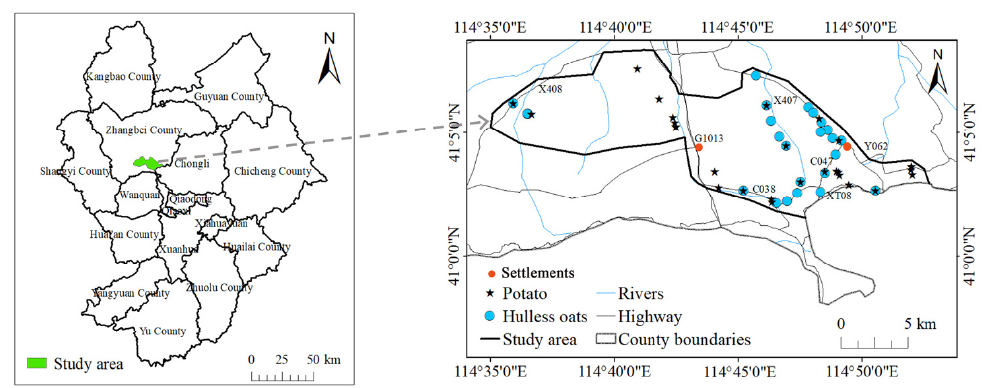
Figure 1. Locations of soil sample points in Zhangbei county, Hebei province, China.